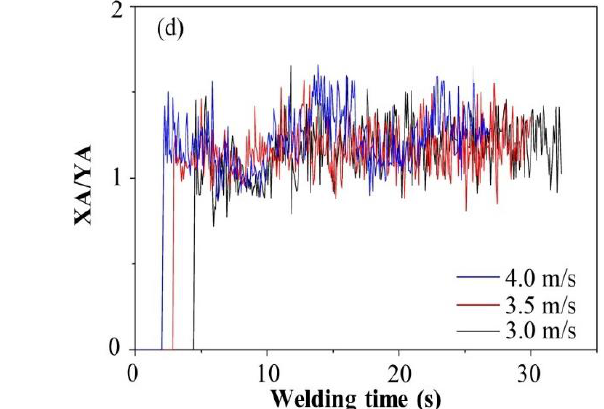
Table 3. Mean value of keyhole characteristic parameters under different welding